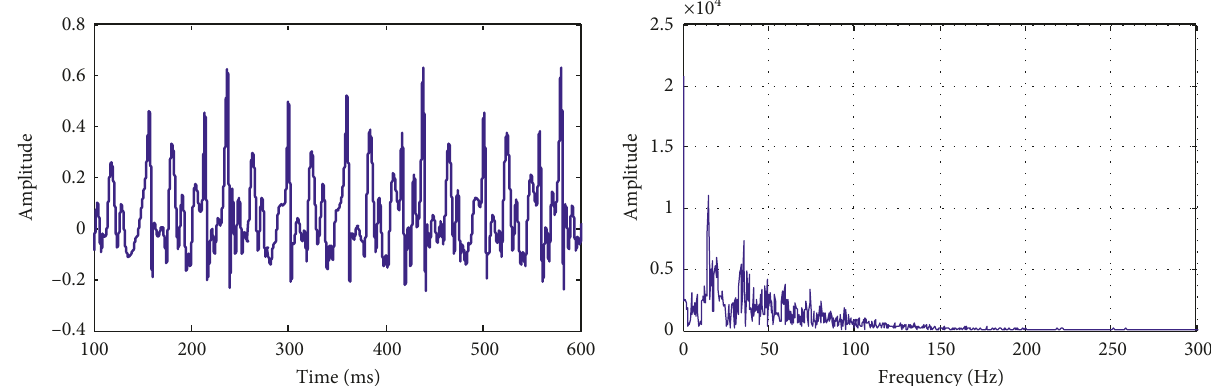
Figure 11: Vertical vibration amplitude signals and its frequency diagram on left bearing.